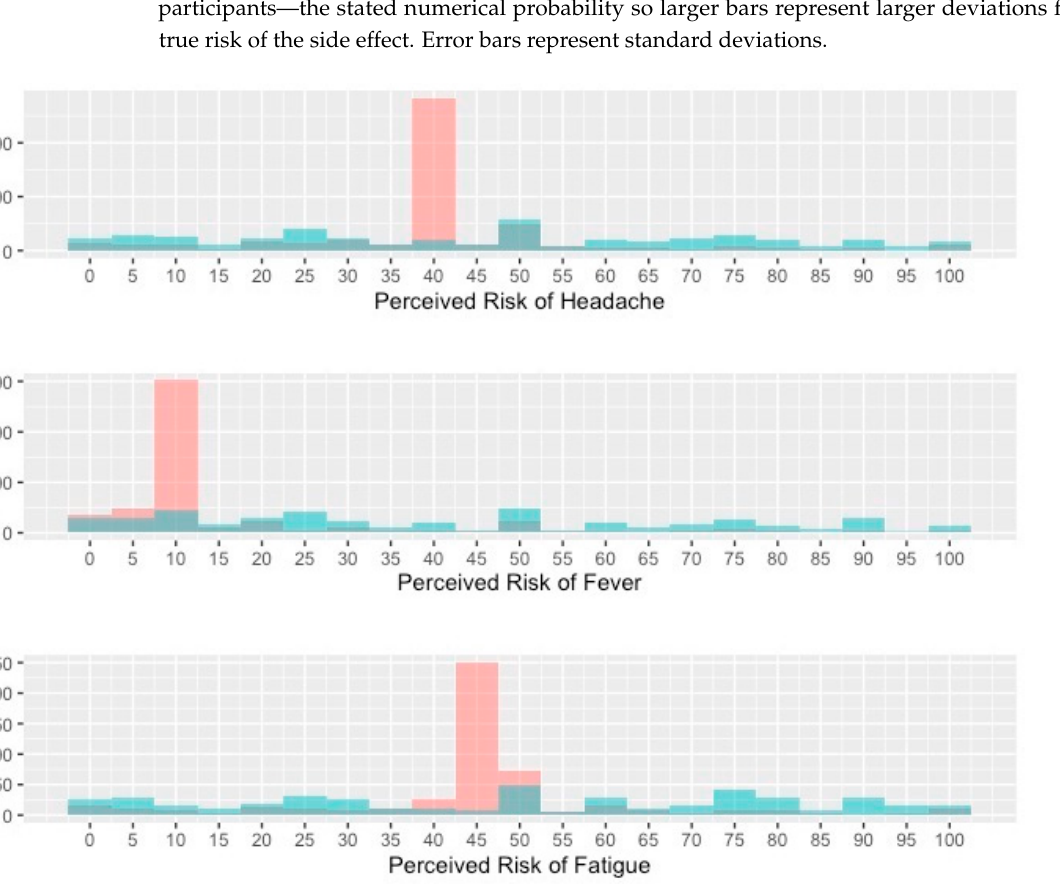
Figure 2. Histograms of participants perceived risk for each complication demonstrating increased variability in risk estimates with verbal probability descriptors. Red bars represent numerical probability descriptors and green bars represent verbal probability descriptors.